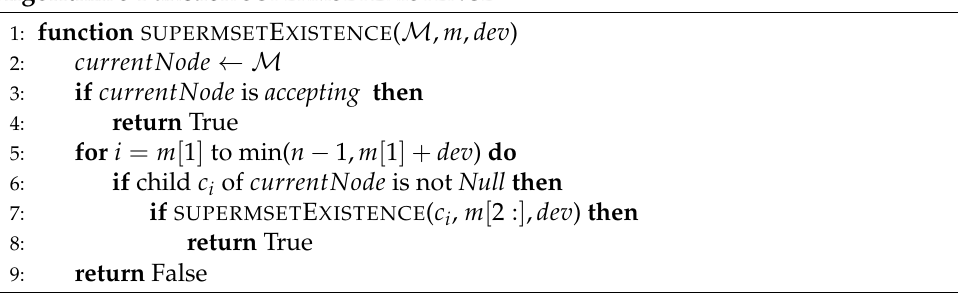
Algorithm 5 Function SUPERMSET E XISTENCE